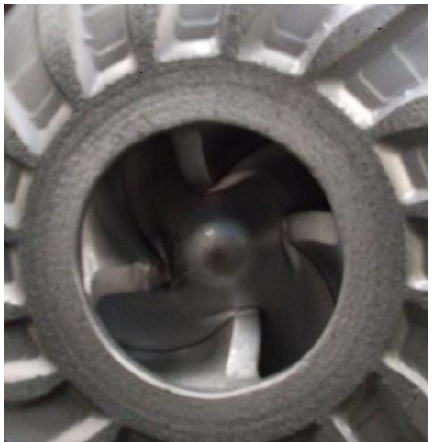
Figure 20. Photograph of impeller wear in the first stage (at the inlet).